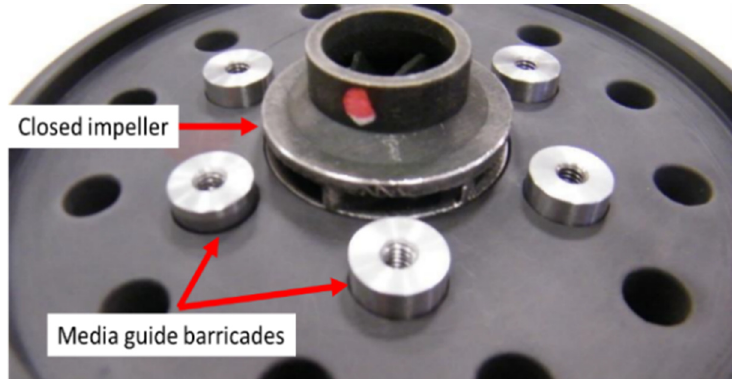
Figure 9. Blade thickness values measured using a caliper with an average of 3 values with respect to computer-aided design (CAD) model.